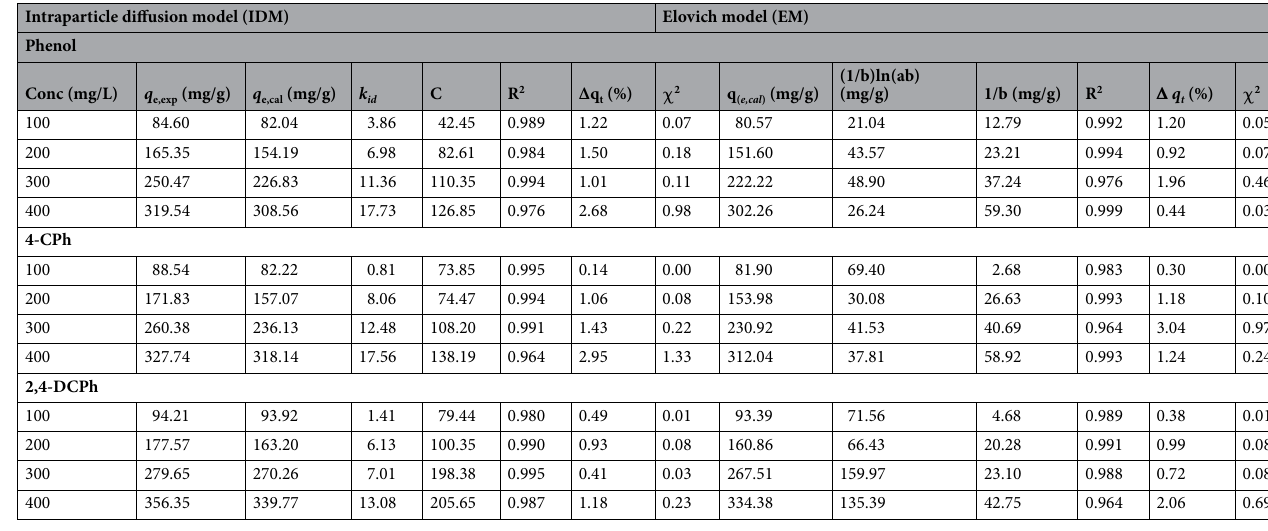
Table 3. IDM and EKM kinetic parameters of phenol, 4-CPh and 2,4-DCPh on WAS-BC.